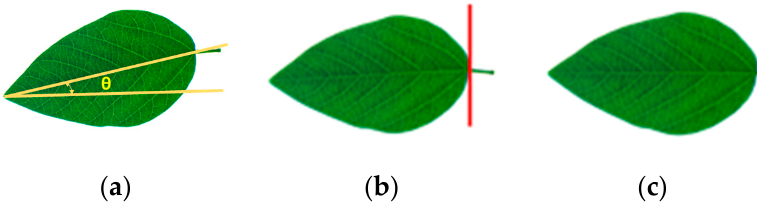
Figure 3. The procedure to remove the petiole in the image. ( a ) Raw image, θ is the angle between the major leaf axis and the image’s x -axis. ( b ) Rotated image with the cutting line. ( c ) Result image.